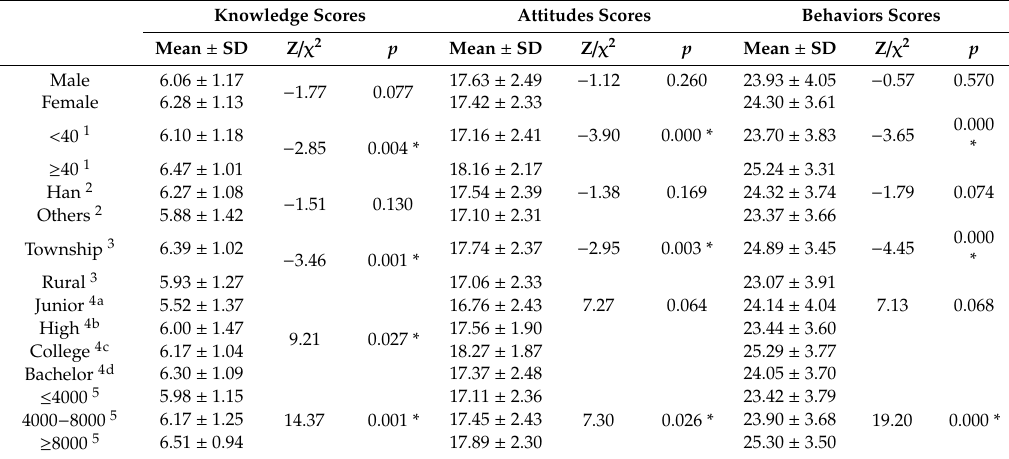
Table 3. Univariate analysis of knowledge, attitude, and practice (KAP) risk factors related to food safety ( n =